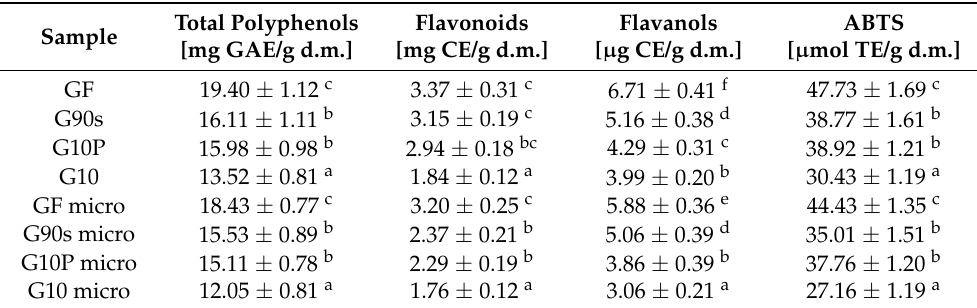
Table 3. The content of selected bioactive compounds and the antioxidant activity (ABTS) of fresh and thermally processed garlic ( Allium sativum